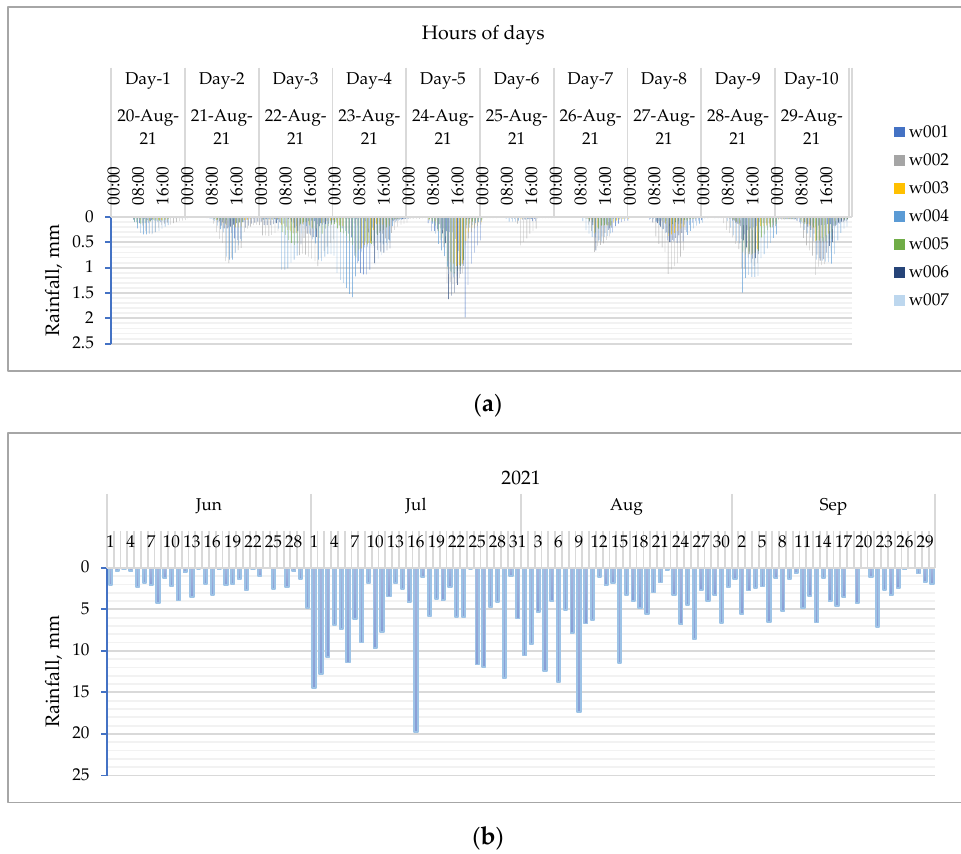
Figure 6. Rainfall forecasts for ( a ) real-time forecast indicating accumulated hourly rainfall (20–29 of August 2021), and ( b ) seasonal forecast indicating daily mean rainfall for the 2021 flood season.